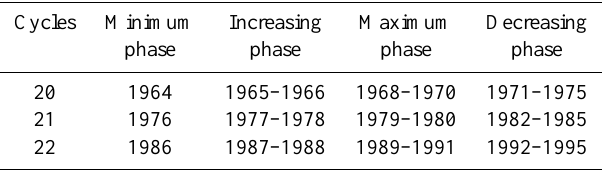
Table 1. Years of the different solar cycle phases.